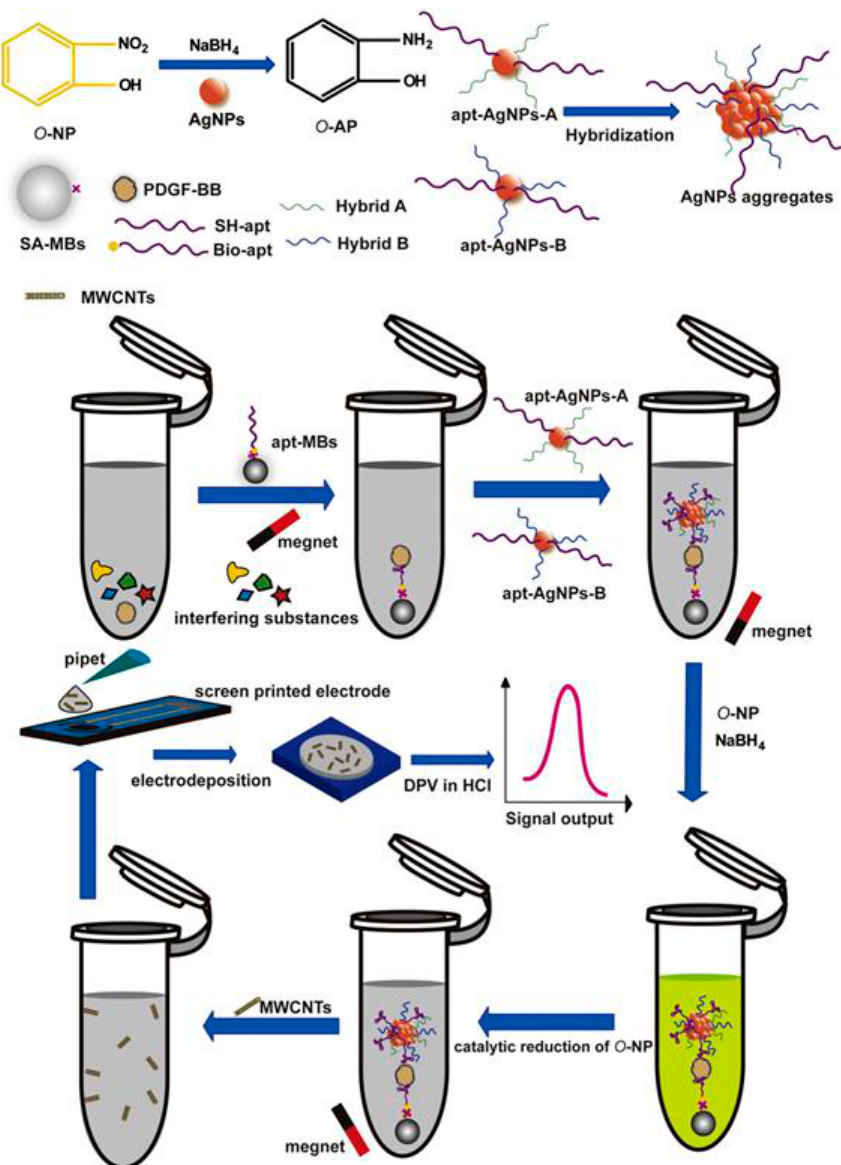
Figure 4. Schematic representation of DNA biosensor using AgNP labeling, multiwalled carbon nanotube modifiers of screen-printed electrode and MBs for enhanced sensitivity and selectivity. Reproduced from [31], with permission from Elsevier, 2019.